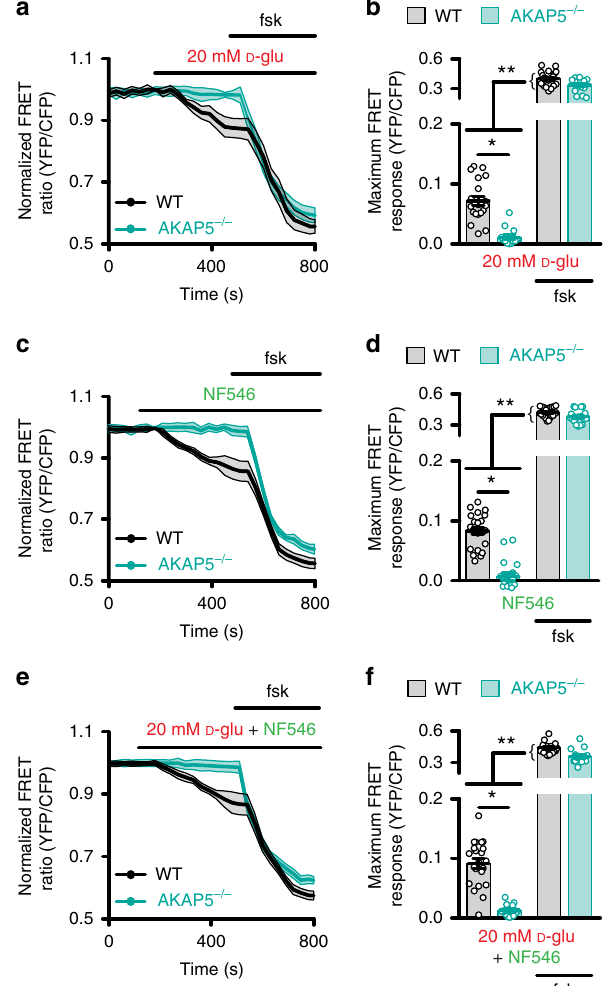
Fig. 2 AKAP5 is necessary for glucose/NF546-induced cAMP synthesis. Averaged ICUE3-PM FRET traces (mean = solid line; SEM = shade) and plot of maximum FRET ratio for wild-type (WT) and AKAP5 − / − male arterial myocytes in response to a , b 20 mM D-glucose (D-glu; n = 21 cells/ 6 WT mice; n = 13 cells/6 AKAP5 − / − mice), c , d 500 nM NF546 ( n = 23 cells/6 WT mice; n = 18 cells/6 AKAP5 − / − mice), and e , f 20 mM D-glu + NF546 ( n = 22 cells/6 WT mice; n = 13 cells/6 AKAP5 − / − mice) and 1 µ M forskolin. * P < 0.05 with two-tailed Mann – Whitney test. The single asterisks highlight signi fi cant differences between datasets in the absence of forskolin. The double asterisks indicate a statistical difference within the same experimental group in the absence and presence forskolin. All signi fi cant P values are <0.0001. Data represent mean ± SEM. Source data are provided as Source data fi